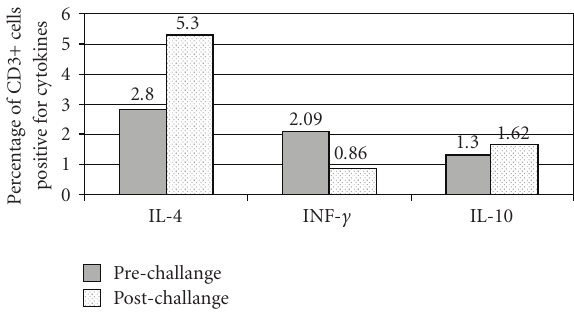
Figure 1: Cytokines expression levels before and after a challenge with rice triggering a FPIES attack in an 8-month old